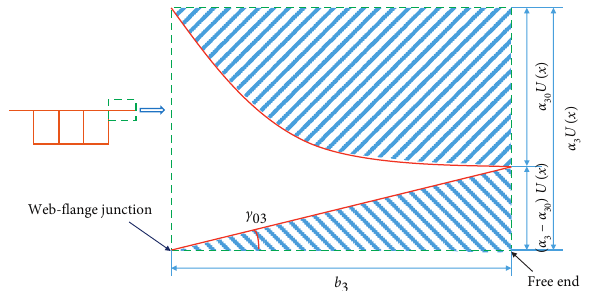
Figure 3: Initial shear deformation in the top lateral cantilever